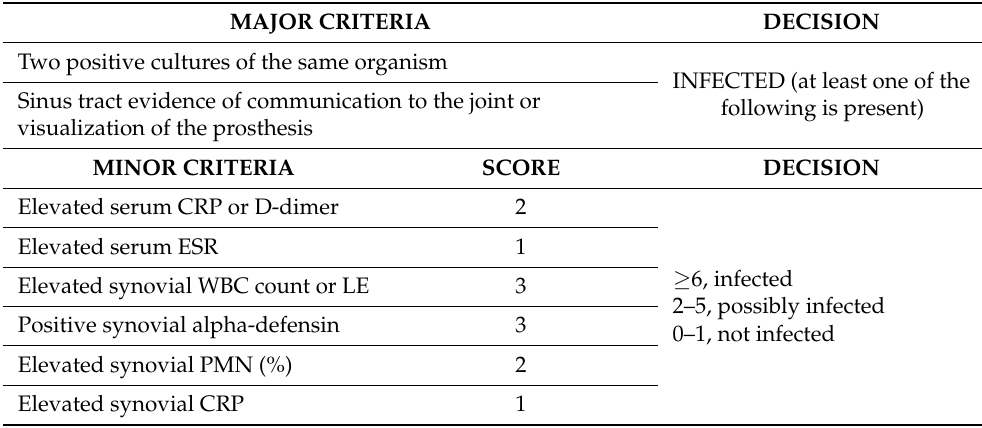
Table 1. 2018 ICM criteria for PJI